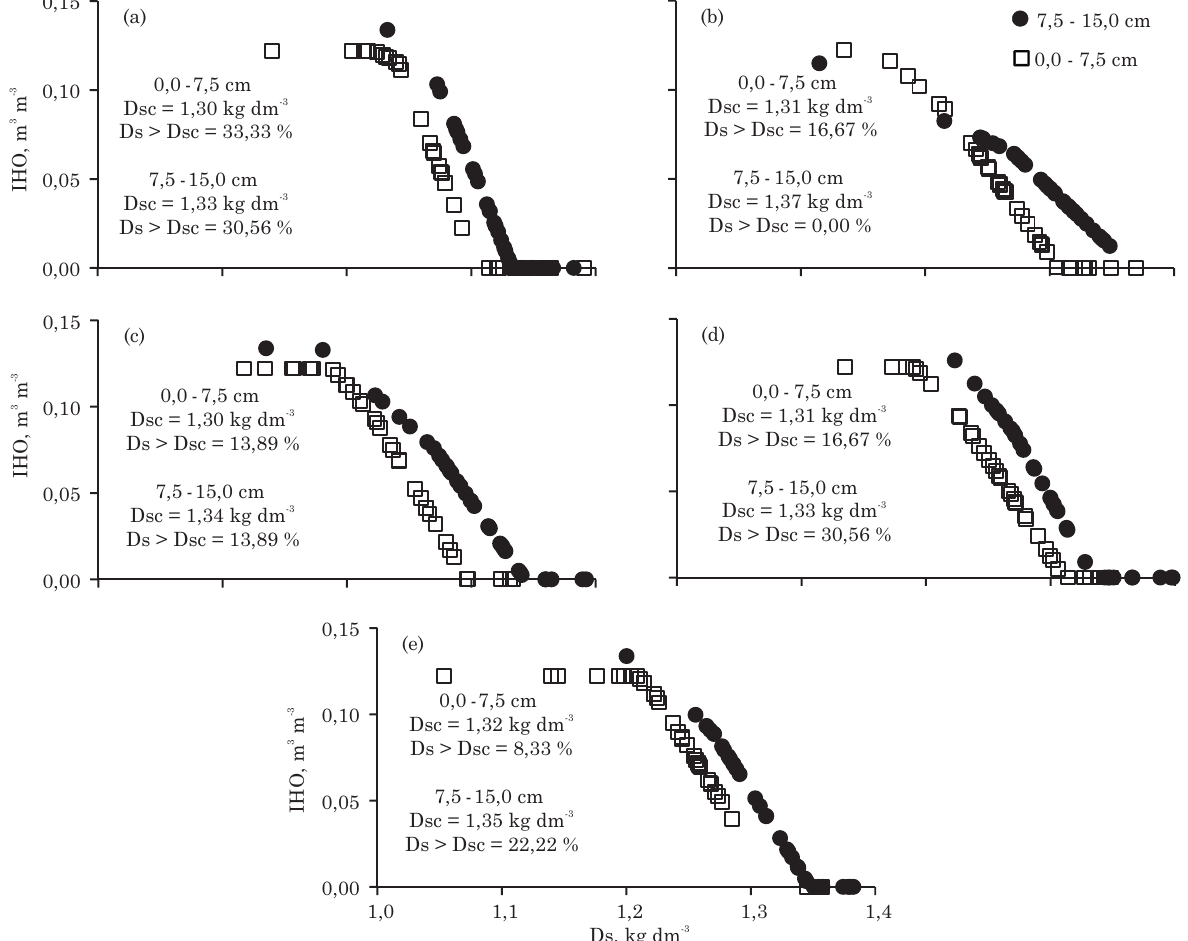
Figura 5. Variação do intervalo hídrico ótimo (IHO) com a densidade do solo (Ds) nos tratamentos 7 cm (a), 14 cm (b), 21cm (c), 28 cm (d) e testemunha (e), nas profundidades de 0,0-7,5 e 7,5-15,0